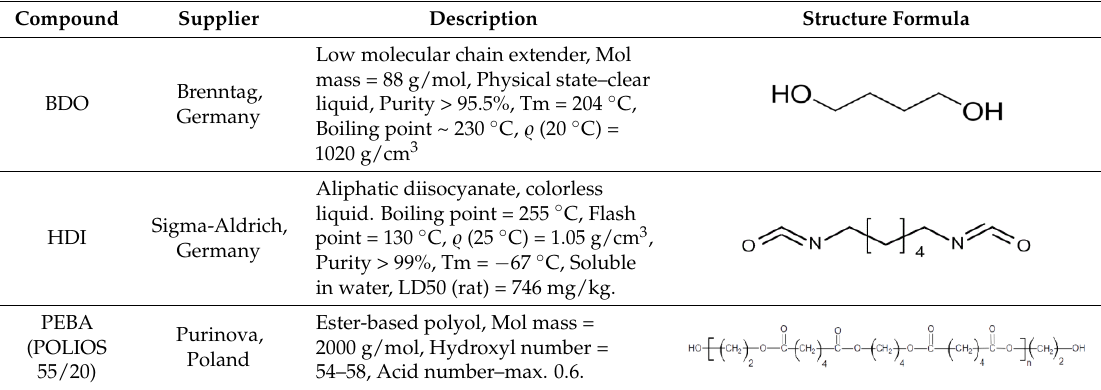
Table 1. Characteristic and chemical structure of used raw materials for the S-TPUs synthesis.